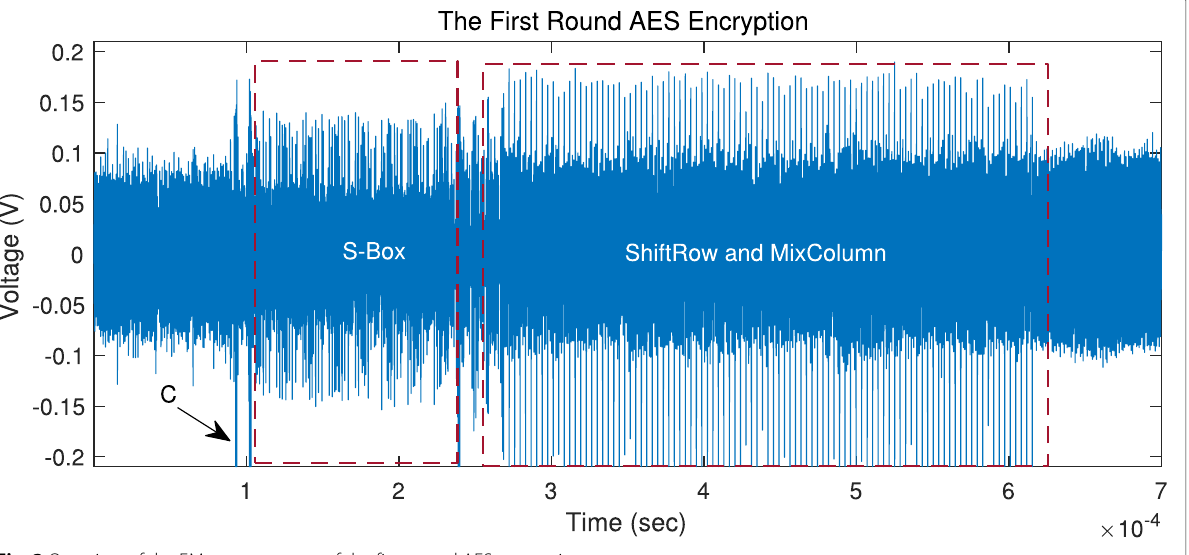
Fig. 3 Overview of the EM measurement of the first round AES